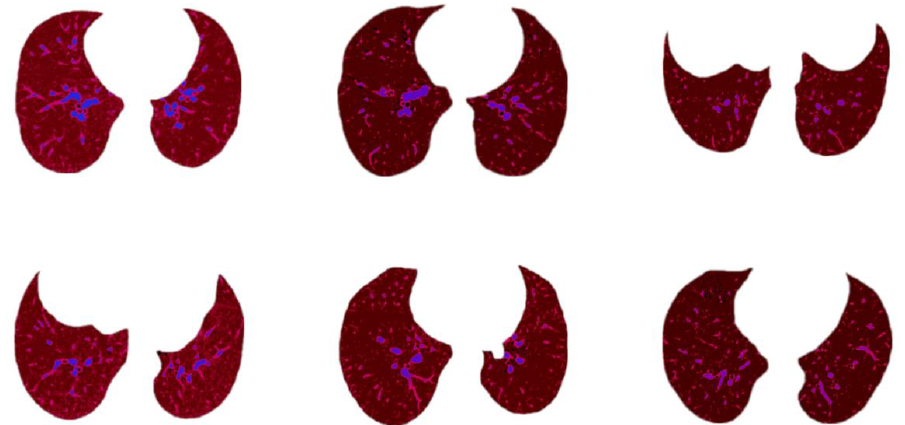
Figure 24. Sample outputs of clustering approach.